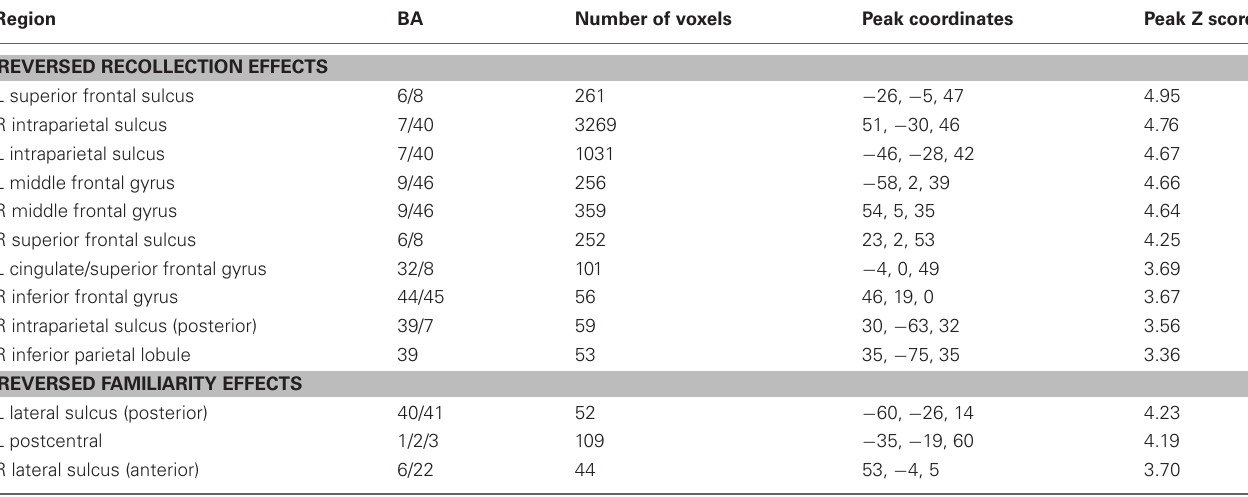
Table 3 | Regions exhibiting “reversed” recollection and familiarity effects.